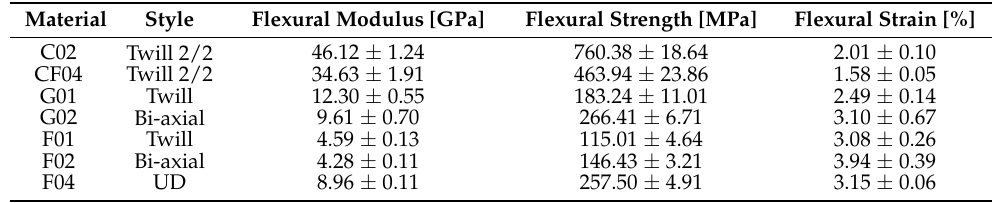
Table 5. Flexural properties of samples.